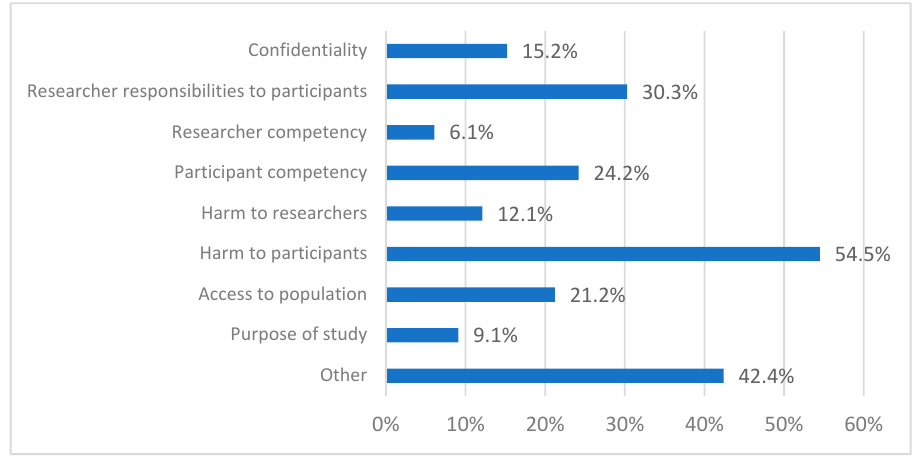
Figure 1. Concerns raised by ethics committees 1 . 1 Total is >100% because multiple answers were allowed.